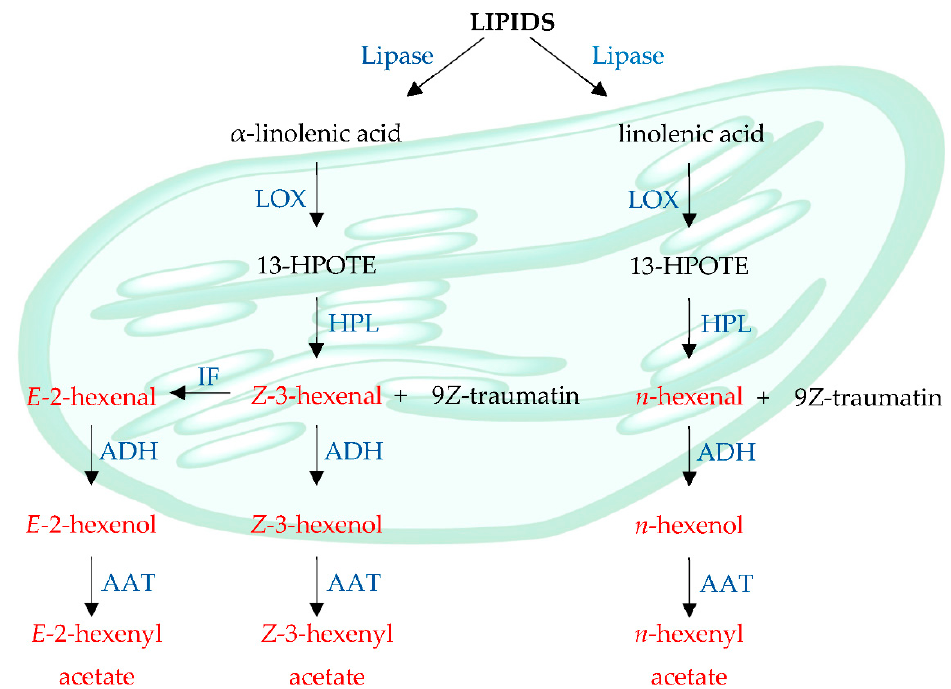
Figure 5. Scheme of the biosynthesis of volatile compounds via lipoxygenase.